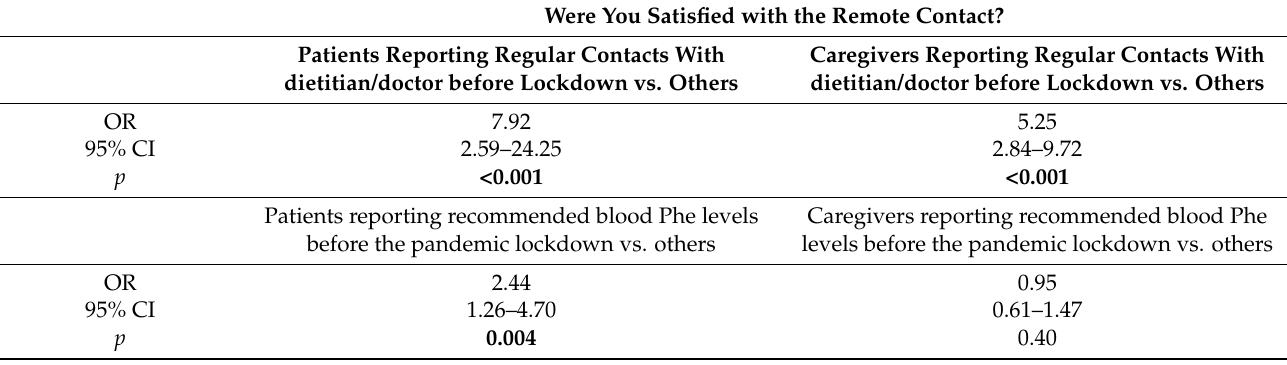
Table 5. Self-reported satisfaction from remote contact with doctor/dietitian depending on contacts with doctor/dietitian and self-reported blood Phe levels before the pandemic lockdown. Were You Satisfied with the Remote Contact? Patients Reporting Regular Contacts With dietitian/doctor before Lockdown vs. Others